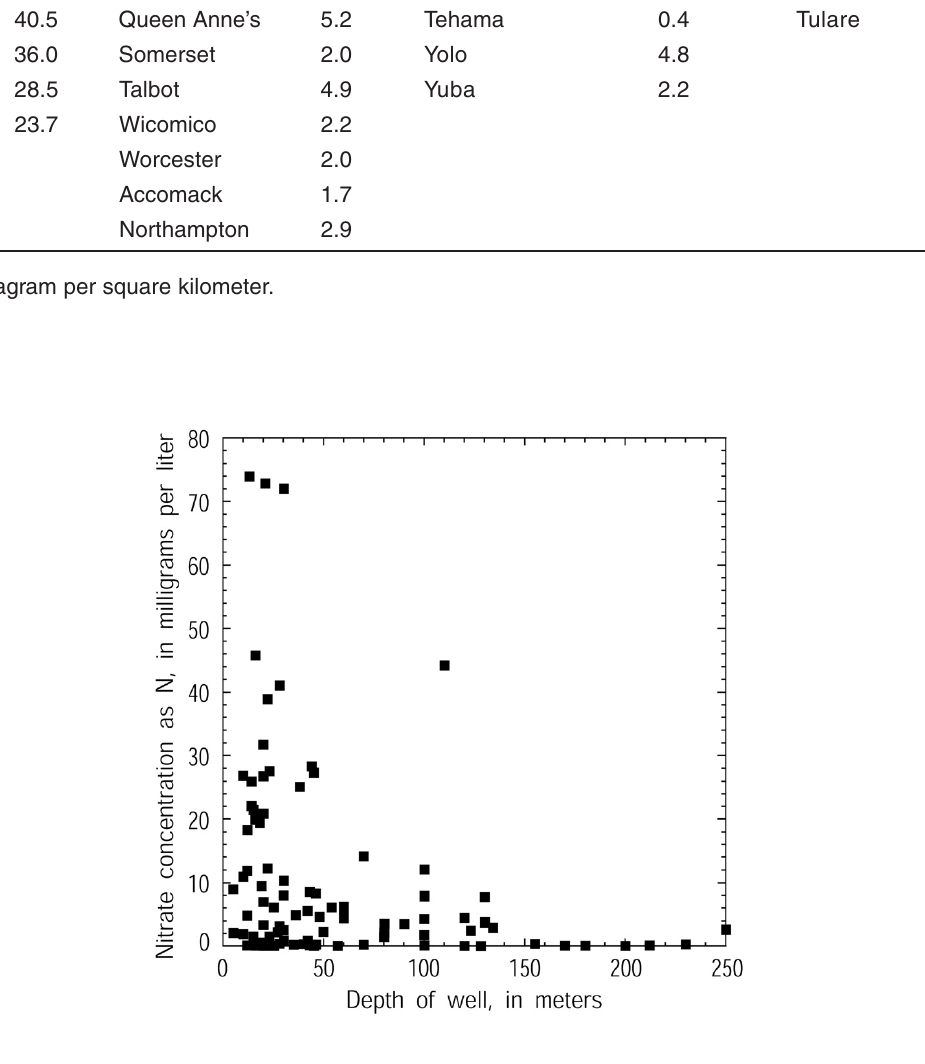
FIGURE 8. Nitrate concentration versus well depth for wells of the Tangshan study